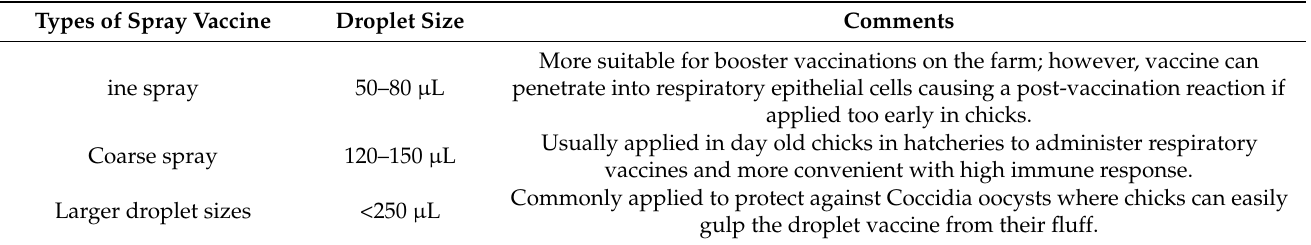
Figure 8. Different vaccination methods for respiratory infectious bronchitis virus. ( A – C ) Spray vaccine in hatchery; ( D ) oculonasal; ( E ) Intramuscular injection; ( F ) Gel-Pac vaccination of Cocci combined with IBV live vaccine (Sources: www.immucox.com, accessed on 29 December 2020). Table 1. Different types of spray vaccines with droplet size applied in poultry (source: www.wattagnet.com/articles/16484 [136].)